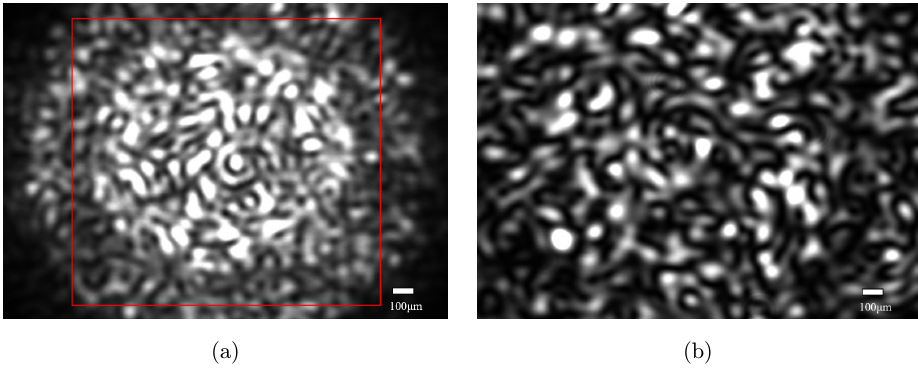
Fig. 2. Typical speckle patterns from an MMF (a) and a scattering medium (b). The scalar bars represent 100 (cid:1) m. Red box indicates the ROI.